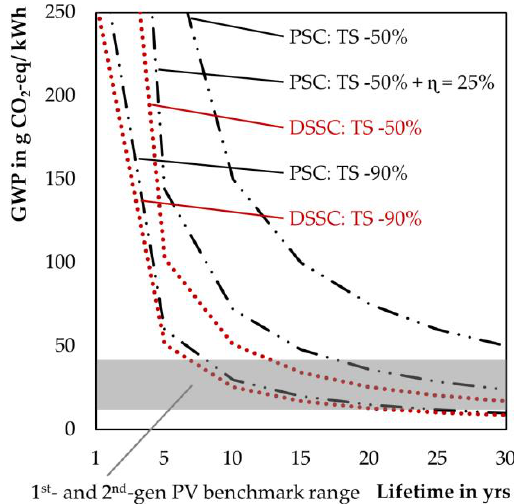
Figure 6. Summary of the scenario analyses of the three influencing factors, efficiency, lifetime, and upscaling, for perovskite solar cells (PSC) and dye-sensitized solar cells (DSSC); the single-scenario analyses of each combination of the influencing factors are given in Figure S2 (Supplementary Materials).